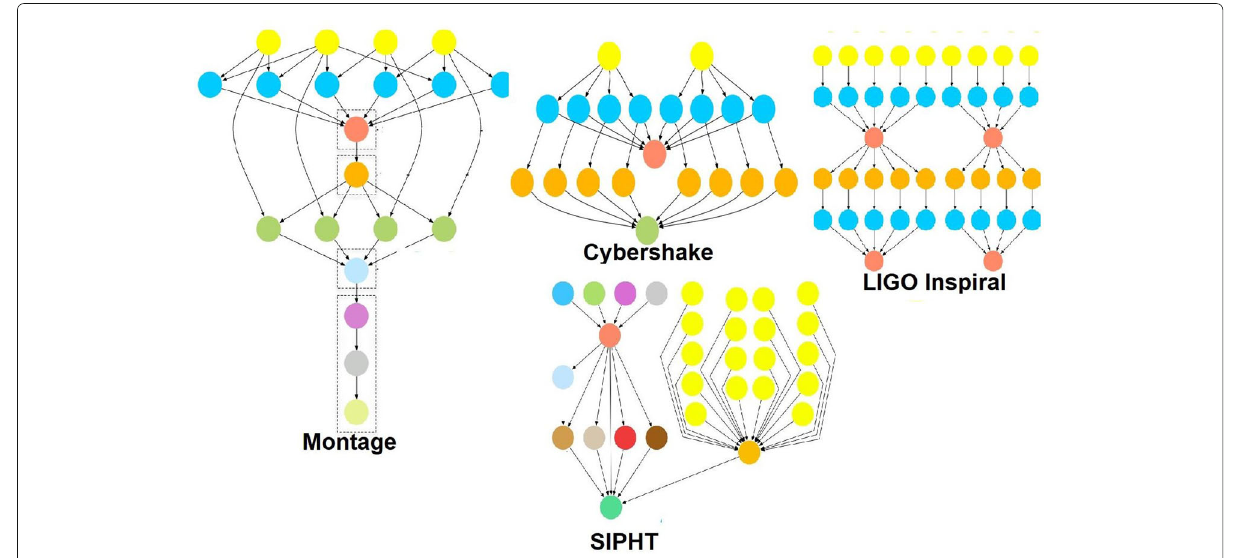
Fig. 4 Structure of scientific workflows used